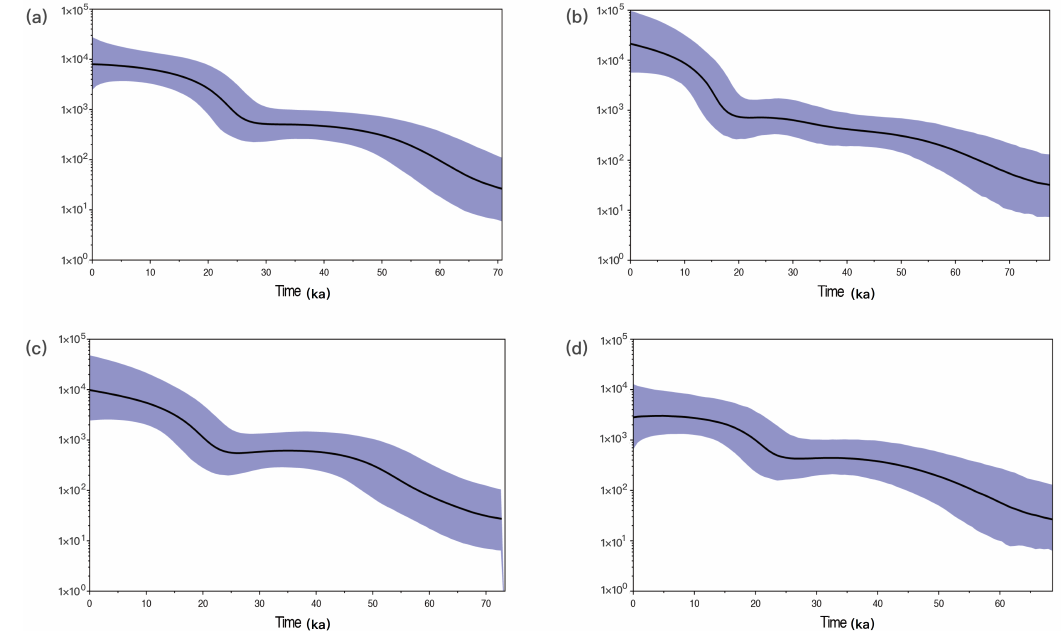
Figure 4. The Bayesian skyline plot (BSP) analyses are performed with the complete mitochondrial sequences to detect the demographic history of Hui ( a ), CHB ( b ), CHS ( c ), and MIN ( d ) populations. The Y -axis represents the assumed e ff ective population size on a logscale. The black lines in bold represent the median population size. The blue line demarcates the boundary of the 95% highest posterior